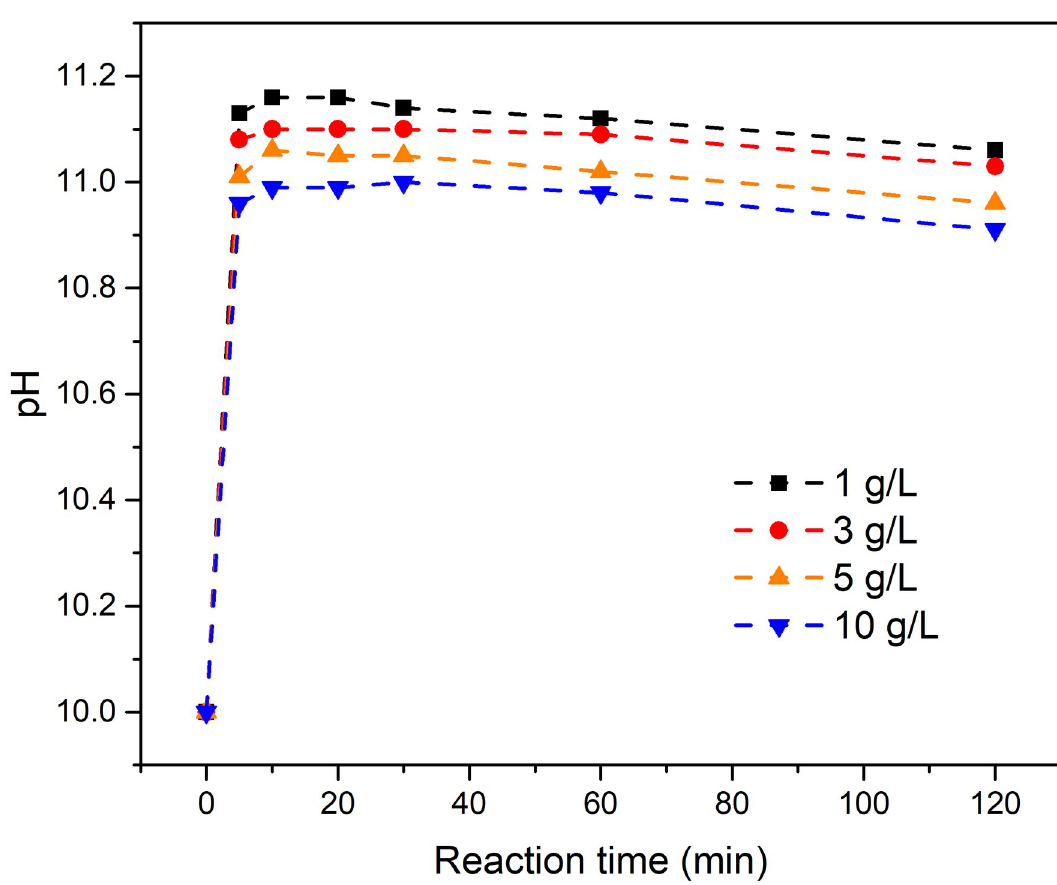
Fig 3. Variation of pH with time at various solid–liquid ratios for